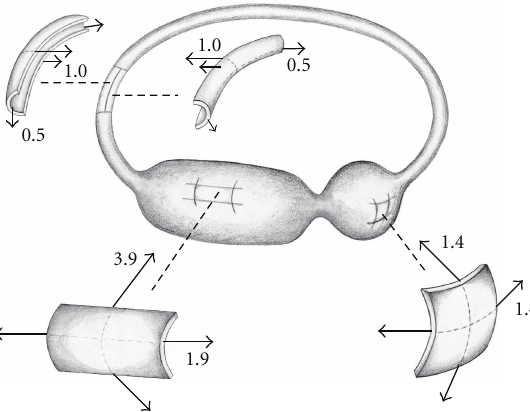
Figure 4: Normalized hoop stress in the oyster toadfish model. The breakout sections reflect the configuration of the membrane ele- ments and indicate the attendant mean normalized stress levels in the di ff erent